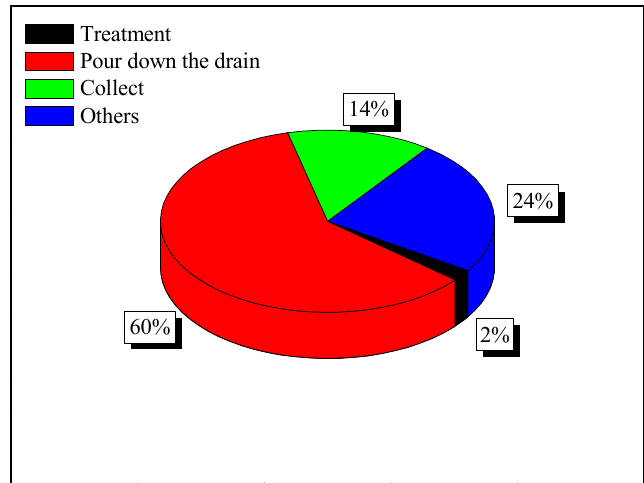
Figure 13. Final disposal of colored wastewater coming from Colombian handicrafts factories.